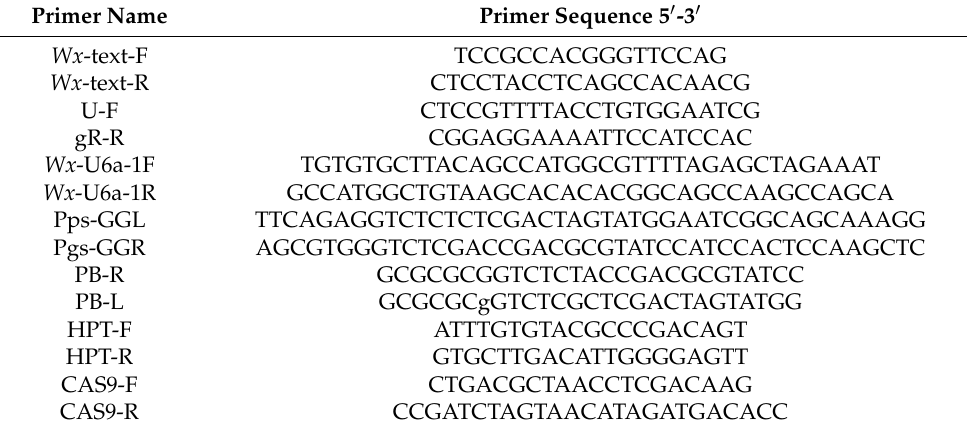
Table 5. Primer sequences used in this